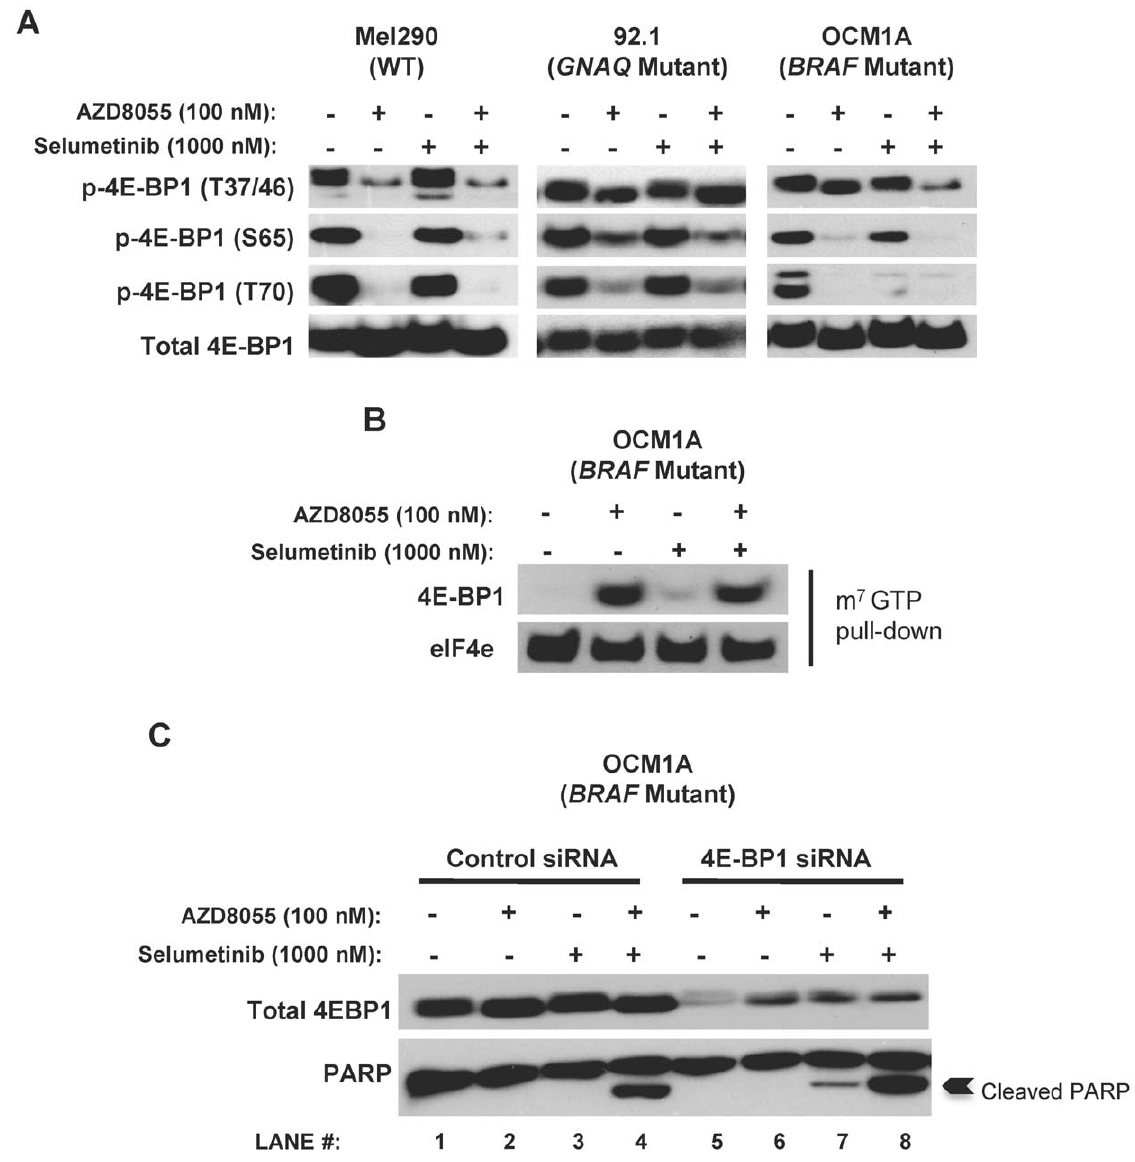
Figure 5. 4E-BP1 phosphorylation is modulated by AZD8055/selumetinib, but does not regulate BRAF mutant cell survival. A, the AZD8055/selumetinib combination cooperatively suppressed 4E-BP1 phosphorylation at T37/46 in the BRAF mutant cell line OCM1A. Cells were treated with the indicated drugs for 24 hours. Western blots were then performed. Total 4E-BP1 was used as a loading control. B, the capability of 4E- BP1 binding to the mRNA cap complex was not impacted by the AZD8055/selumetinib combination in OCM1A cells. A cap binding assay was performed (referenced in the Materials and Methods section). Briefly, cells were treated with the indicated drugs for 24 hours. Cell lysates were created and then incubated with m 7 GTP sepharose beads to capture all 4E-BP1 and eIF4E proteins that are capable of binding to an mRNA cap complex. The bead-associated proteins were analyzed by Western blot. C, suppression of 4E-BP1 expression did not diminish apoptosis as assessed by PARP cleavage in OCM1A cells. Cells were transfected with siRNA constructs targeting 4E-BP1 or unrelated control constructs for 48 hours. Cells were then treated with the indicated drugs for 24 hours. Western blots were performed.